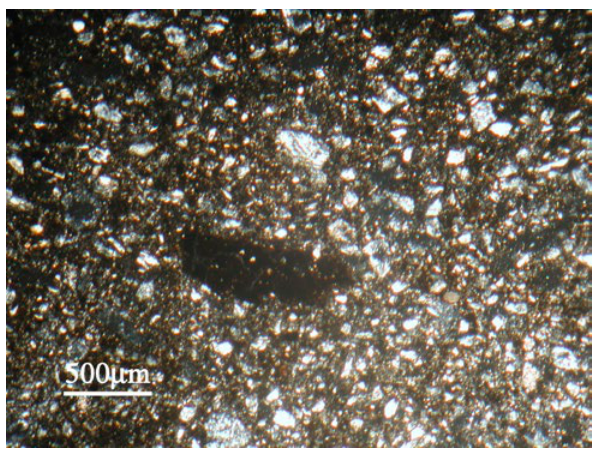
Figura 7. Product M, sample 19 - Cross Nicols image: particular of the gypsum binder with brownish red colour for the presence of iron oxides. Gypsum and quartz, constituting the aggregate, are visible.